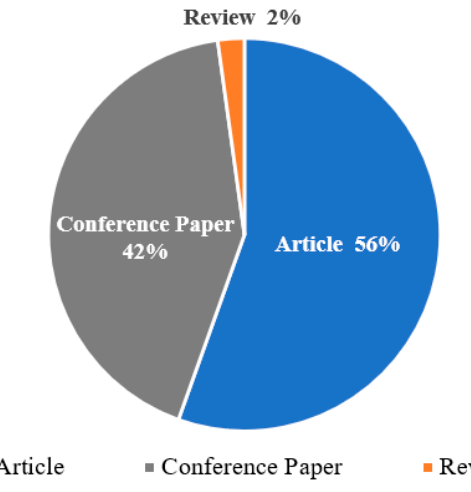
Figure 4. Distribution of literature types.